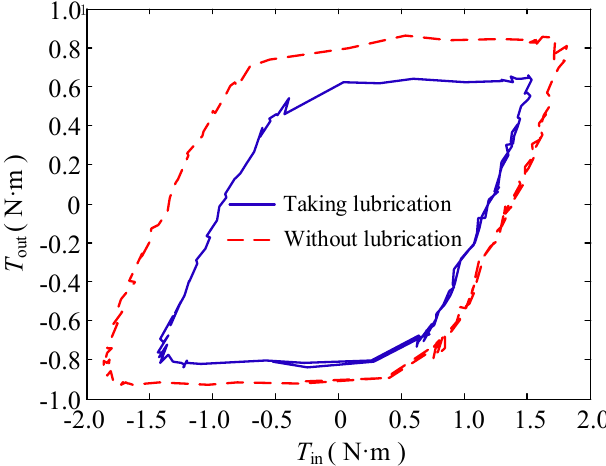
Figure 5. Torque transfer relationship when the lubrication condition changes.